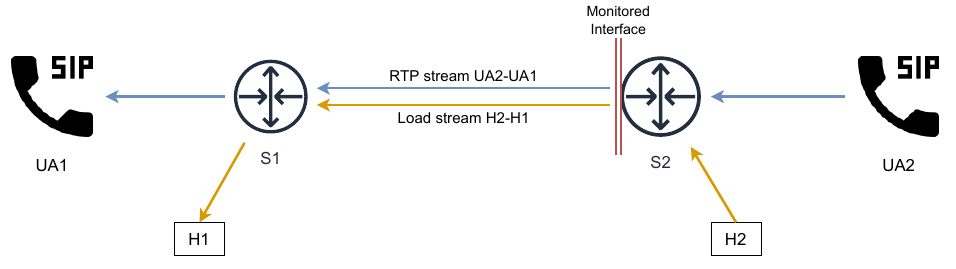
Figure 3. Congestion simulation and traffic capture for QoS